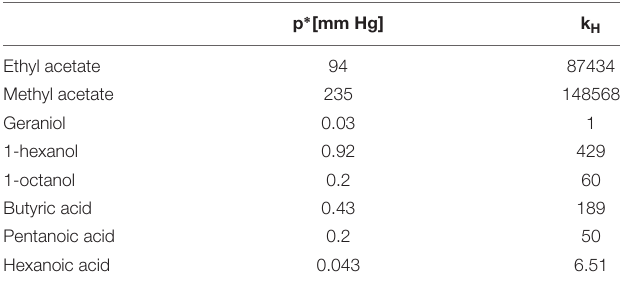
TABLE 1 | Example values for vapor pressure and Henry’s constant in mineral oil extracted from Cometto-Muñiz et al.